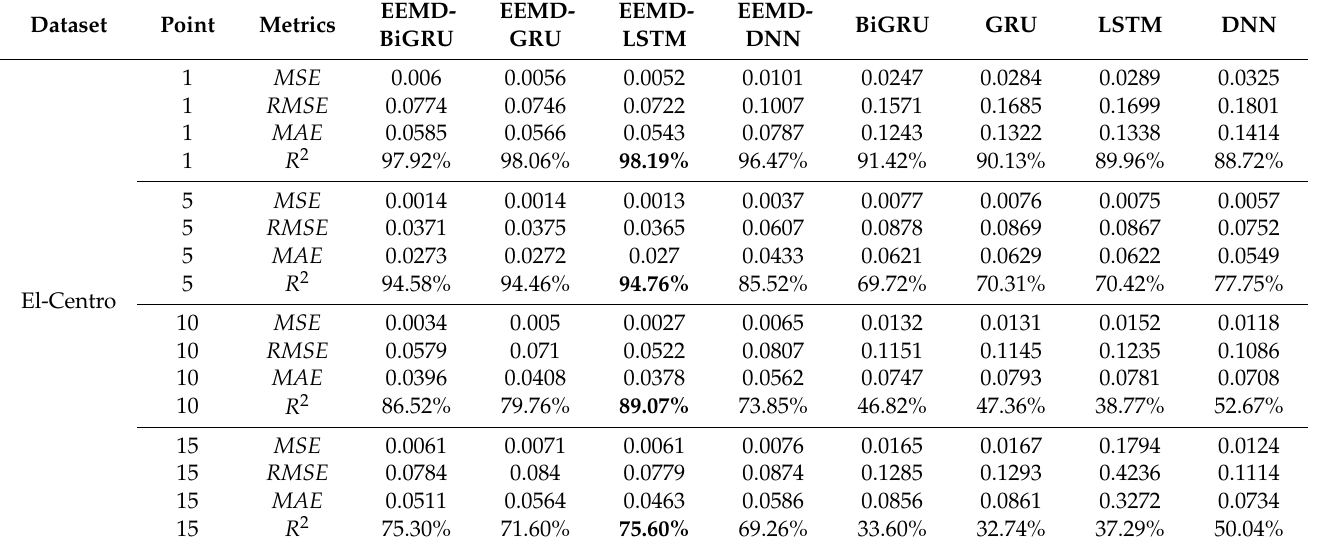
Table A1. Comparison results for the El-Centro dataset using different